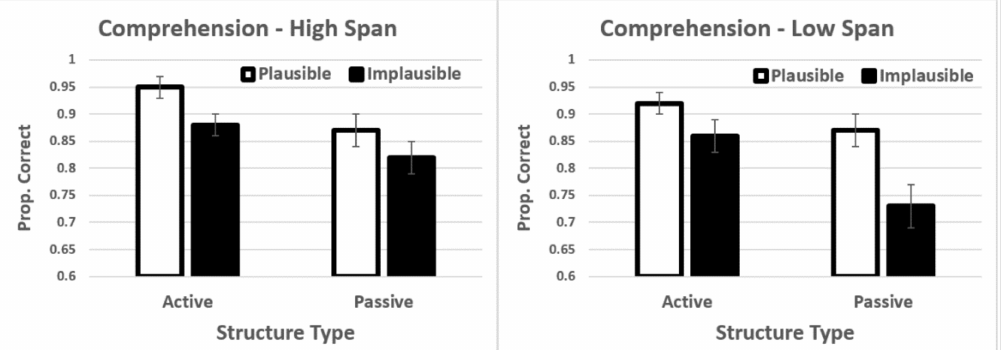
Figure 3. Mean comprehension accuracy by high- and low-span participants. Error bars show the standard error of the